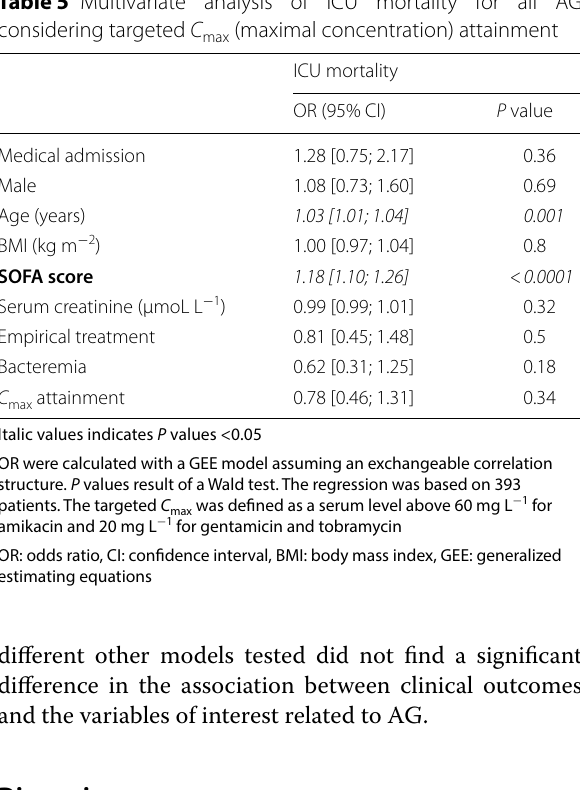
Table 5 Multivariate analysis of ICU mortality for all AG considering targeted C (maximal concentration) attainment max